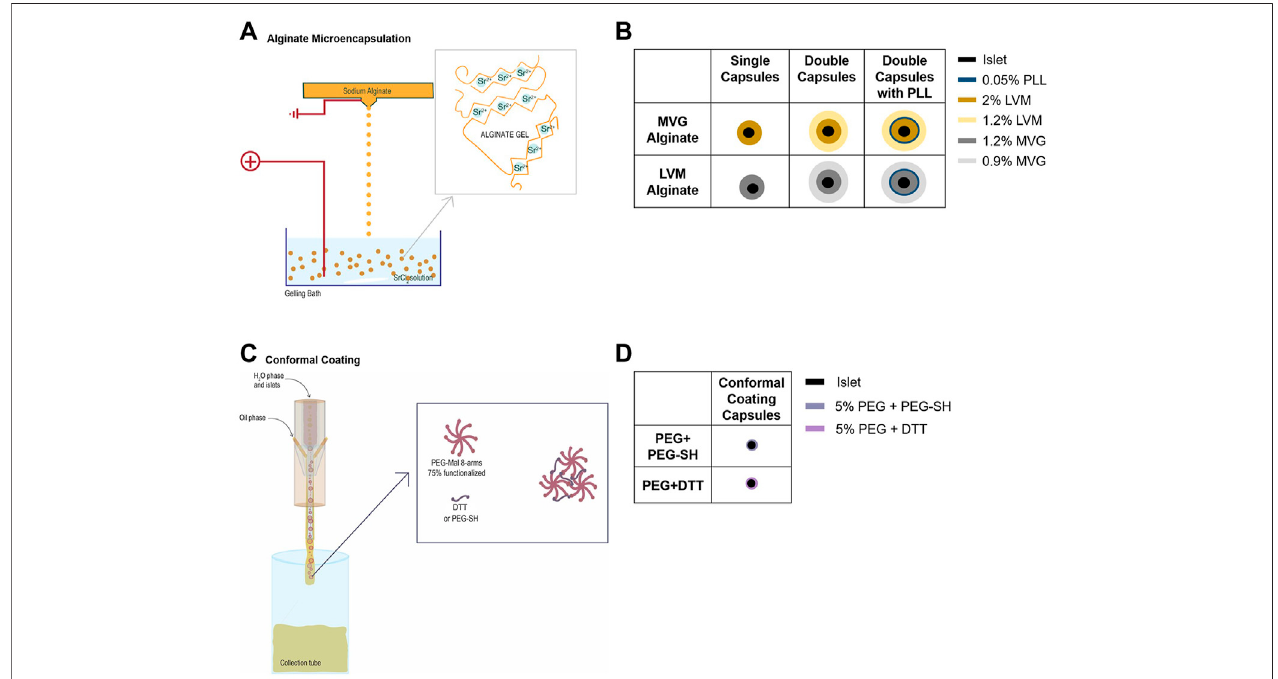
FIGURE 1 | Encapsulation of human islets (HIs) in alginate microcapsules or through polyethylene glycol (PEG) conformal coating (CC). (A – D) Electrostatic microdroplet generator (A) and schematic of MVG and LVM alginate single (SC) and double capsules (DC) with and without PLL (B) . CC device and capsule formation through Michael-type addition reaction (C) and schematic of PEG conformal capsules (D)